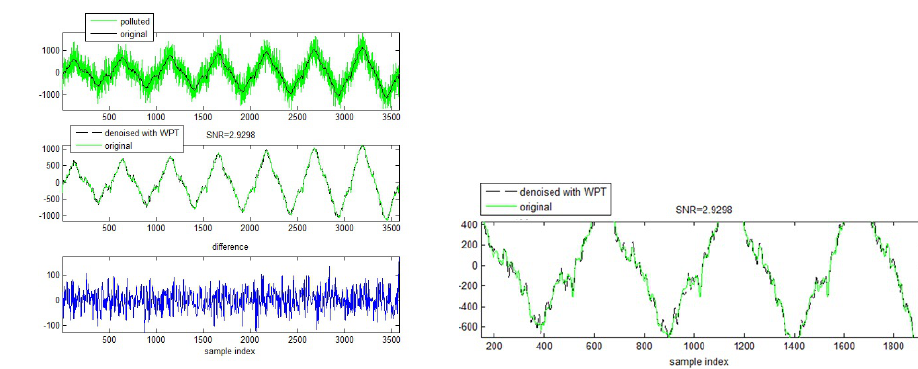
Figure 11. Zoom from Fig.